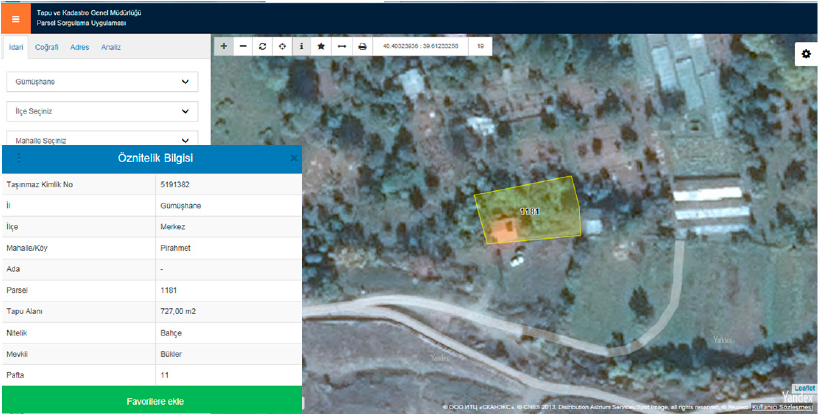
Figure 7. A sample query result with PQA displaying parcel boundaries and attributes. Translation Figure of some of the expressions: ‘Ta ş ı nmaz No’ = ‘Real Estate ID’, ‘ İ l’ = ‘Province’, ‘Mahalle/Köy’ = ‘District/Village’, ‘Tapu Alan ı ’ = ‘Area’, ‘Mevkii’ = ‘Place’, ‘Pafta’ = ‘Map Number’.